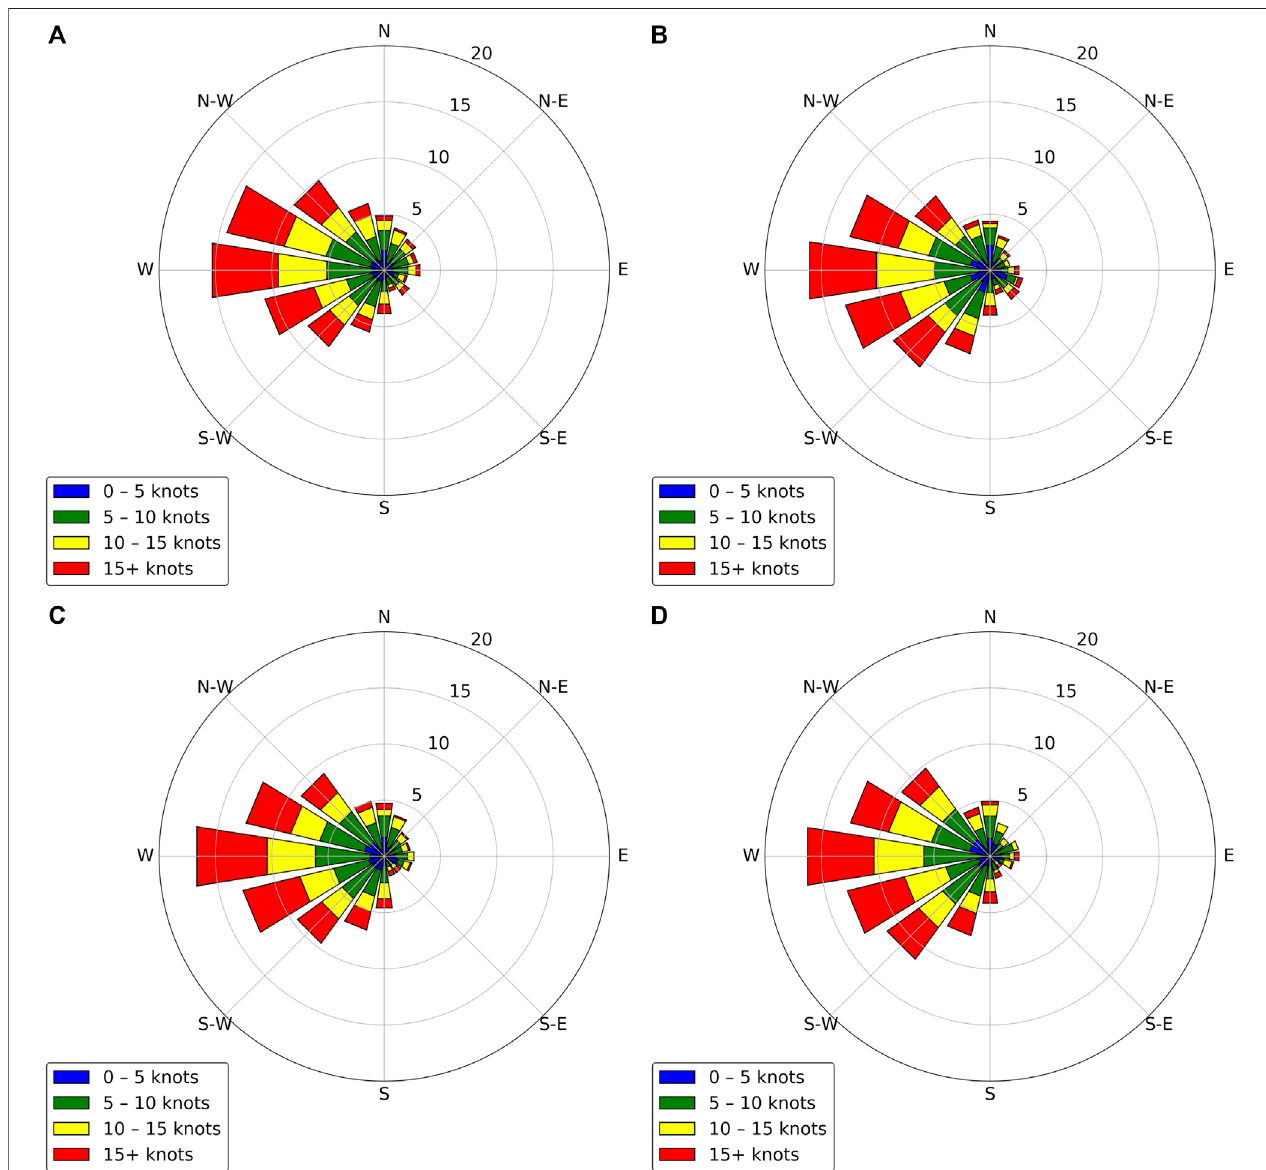
FIGURE 4 | 700 hPa wind roses corresponding to (A) climatology, (B) the Debbage and Shepherd (2015) method of de fi ning URDs, (C) the Mote et al. (2007) method of de fi ning URDs, and (D) the novel method of de fi ning URDs.